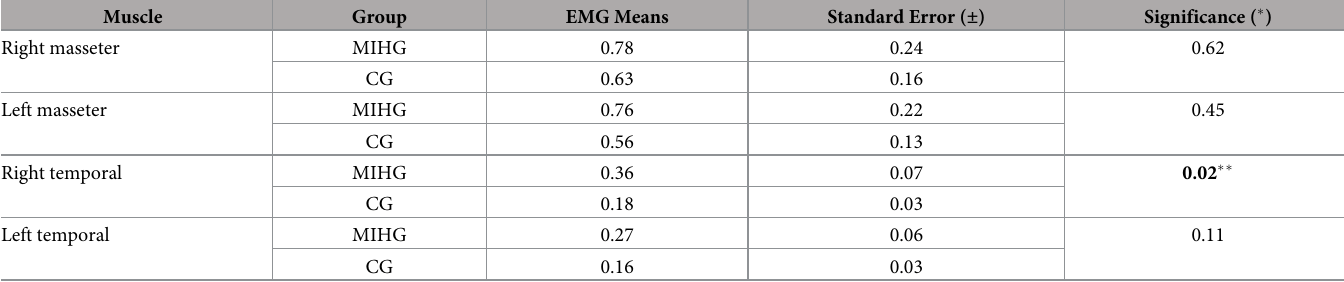
Table 4. Mean values, standard error, and statistical significance (p � 0.05) of the normalized electromyographic data in the maximum protrusion condition, for each muscle evaluated, in the MIH group (MIHG) and control group (CG). Muscle